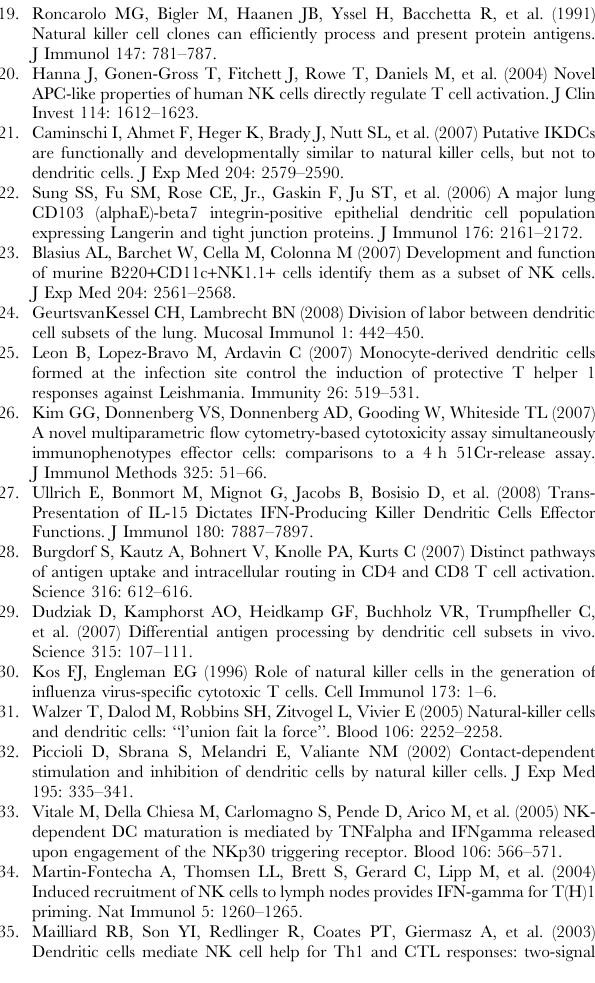
and depicted as geometric mean titer 6 SE. In all experiments at least 5 mice per group were used and values are expressed as mean 6 SEM. * p , 0,05. TIF) Figure S3 Colocalization of NK cells and naı¨ve CD8 T cells in MLN at early time points post infection. Adoptive transfer of naı¨ve Ly5.2 OTI CD8 + cells (reactive to OVA class I epitope) was performed to Ly5.1 recipients, allowing to detect OVA specific CD8 T cells using a Ly5.2 antibody. 1 day later mice were immunized with influenza virus containing the OVA class I epitope (Flu (OVA insert)) or with wild type influenza virus (Flu). At 2 days post infection MLN were stained for NK cells with an antibody against NK1.1. (blue) and Ly5.2 T cells (red).We could observe several NK cells in close proximity to naı¨ve CD8 T cells, but only in mice infected with the virus containing the OVA epitope. Found at: doi:10.1371/journal.pone.0007187.s003 (4.23 MB